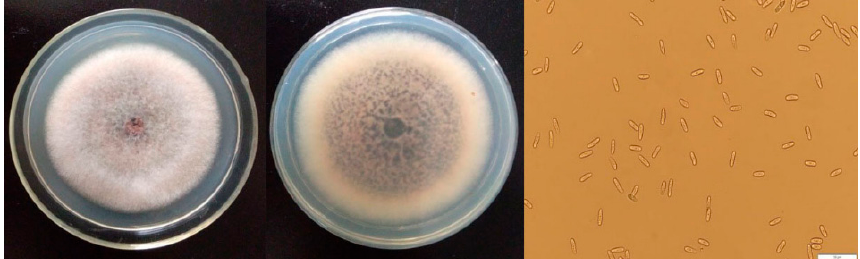
Figure 1. The colony morphology and conidia (after five days incubation) of C. gloeosporioides identified from sweet cherries. from sweet